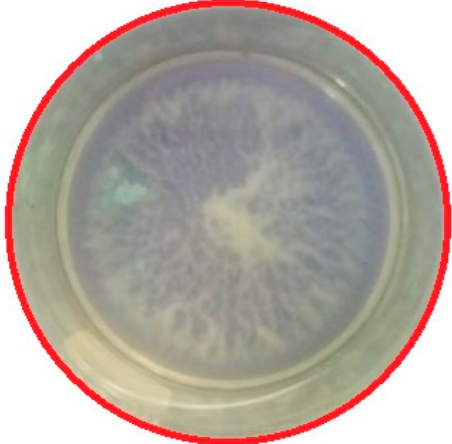
Figure 9. Photographic view of the solid residue produced during plasma treatment of industrial wastewater.